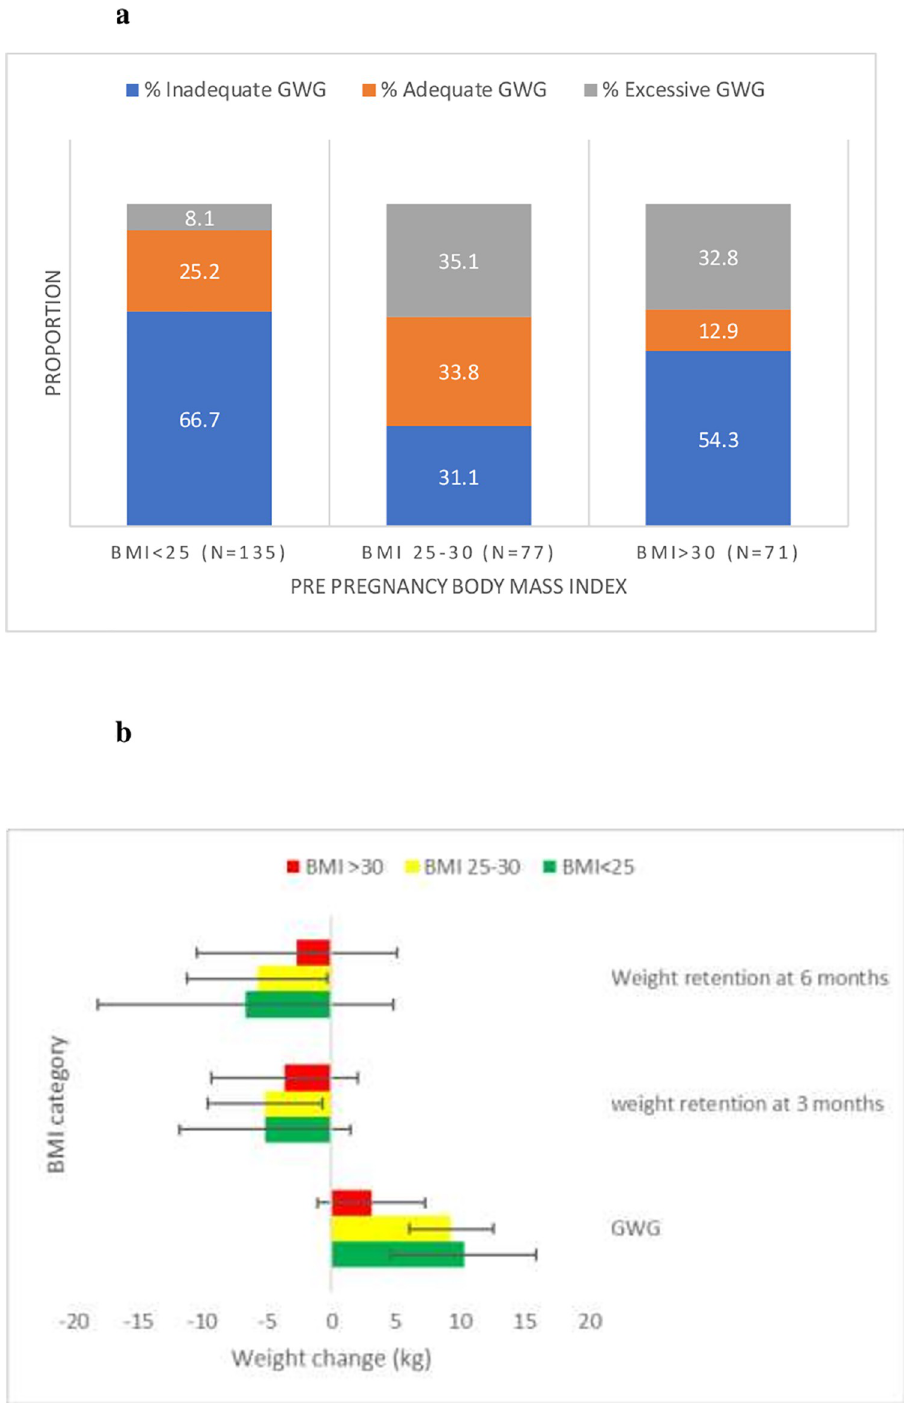
Fig 2. Adequacy of gestational weight gain (a) and post-partum weight retention (b) in Baby-bod mothers.